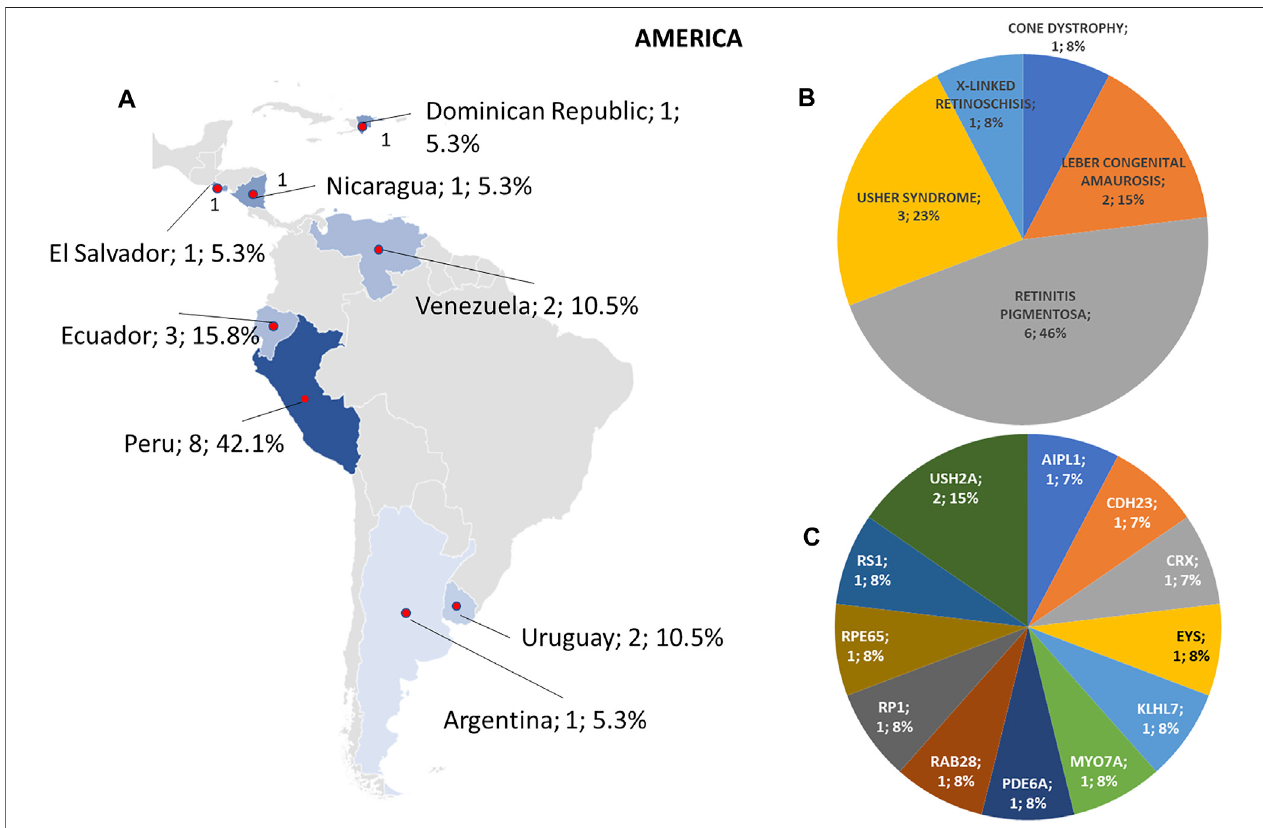
FIGURE4| PhenotypeandgenotypedistributionsinAmericancountries. (A) Themapshowsthenumbersandpercentagesofexaminedpatients.Piechartsshow (B) the phenotypes and (C) genotypes of positive cases.